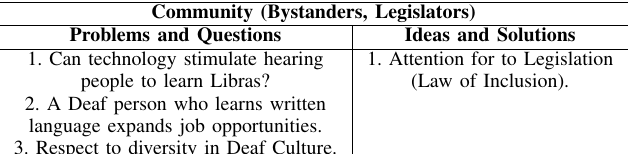
TABLE VI E VALUATION F RAME RESULTS FOR THE C OMMUNITY LAYER Community (Bystanders, Legislators) Problems and